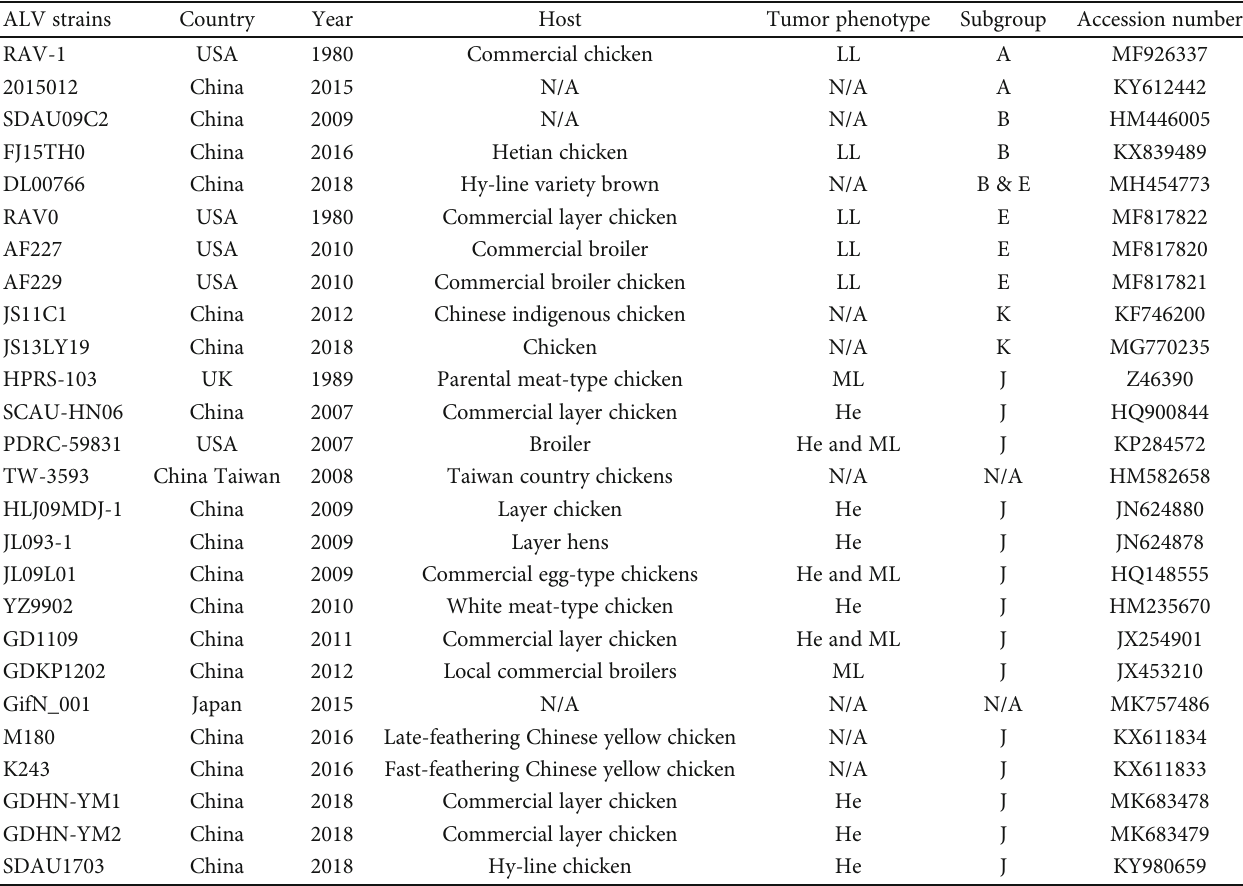
Table 2: The ALV-J reference strains used in this study.